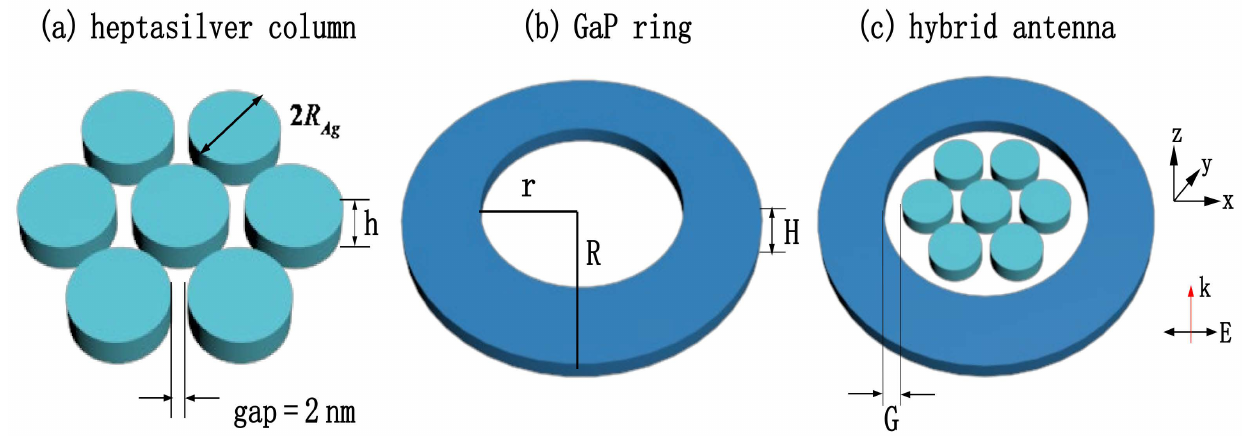
Figure 1. ( a ) Structural parameters and arrangement of the heptamer of silver; ( b ) parameters of the GaP nanoring; ( c ) combination of the heptamer of silver and GaP